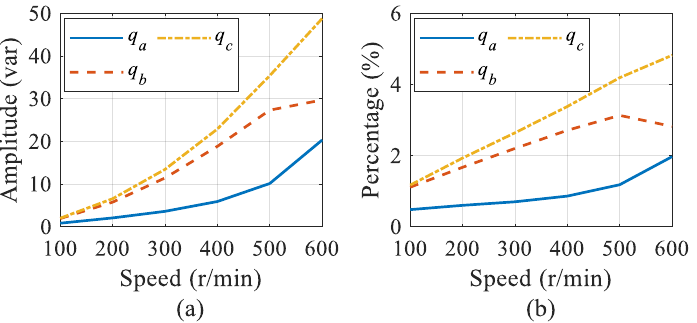
Figure 5. The amplitudes of the second harmonics in IRPs ( a ) and the proposed indicators ( b ), with ITSC, at different speeds. T L was fixed at 10 N∙m. ITSC, at different speeds. T · m. L was fixed at 10 N